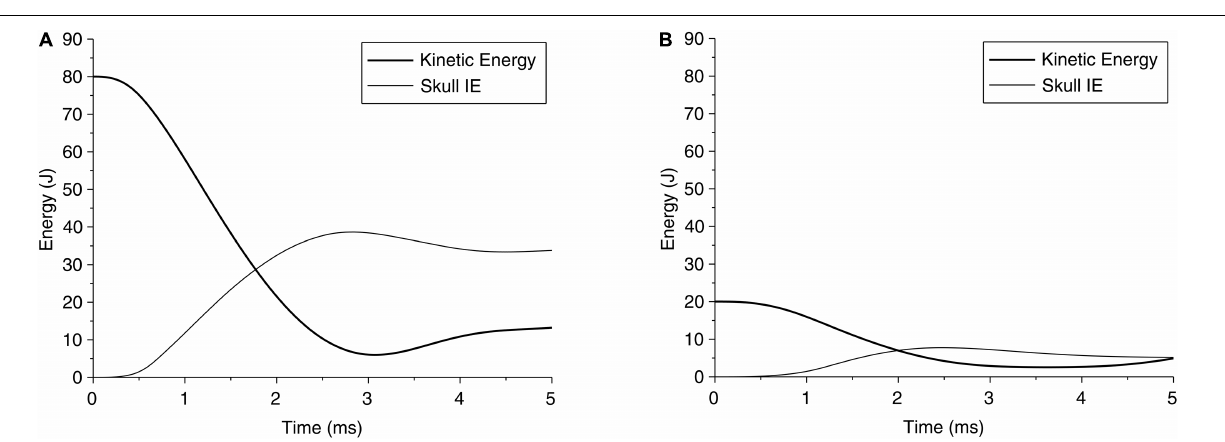
FIGURE 5 | Time history of kinetic energy of the head during impact of head due to a fall, and the internal energy (IE) of skull absorbed by the skull for (A) case 1 and (B) case